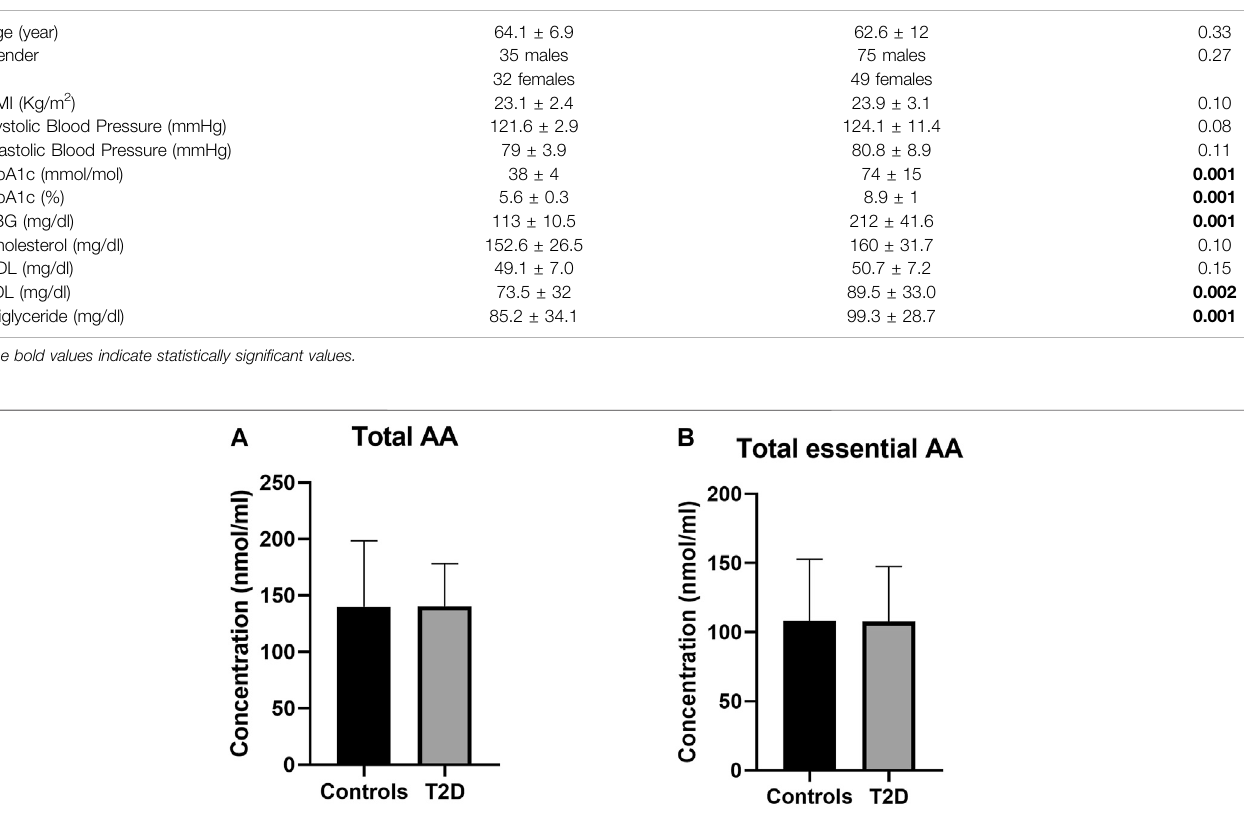
Regulation of Non-essential Amino Acids in T2D In terms of the non-essential amino acids, no statistically